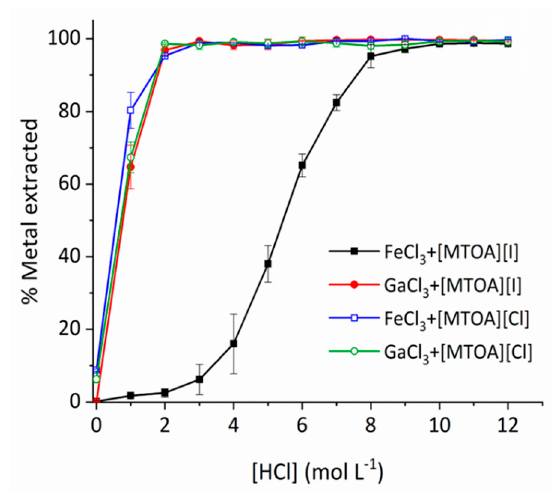
Figure 1. Percentage of gallium and iron extracted by [MTOA][I] at varying [HCl]. Interpolation used to aid the eye only. Experiments were performed in duplicate, and the results are reported as an average.